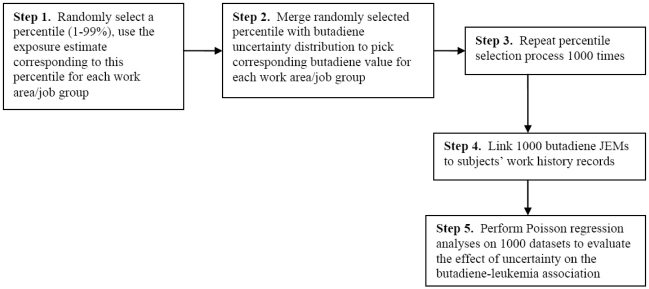
Creation of 1,000 datasets for uncertainty analyses.